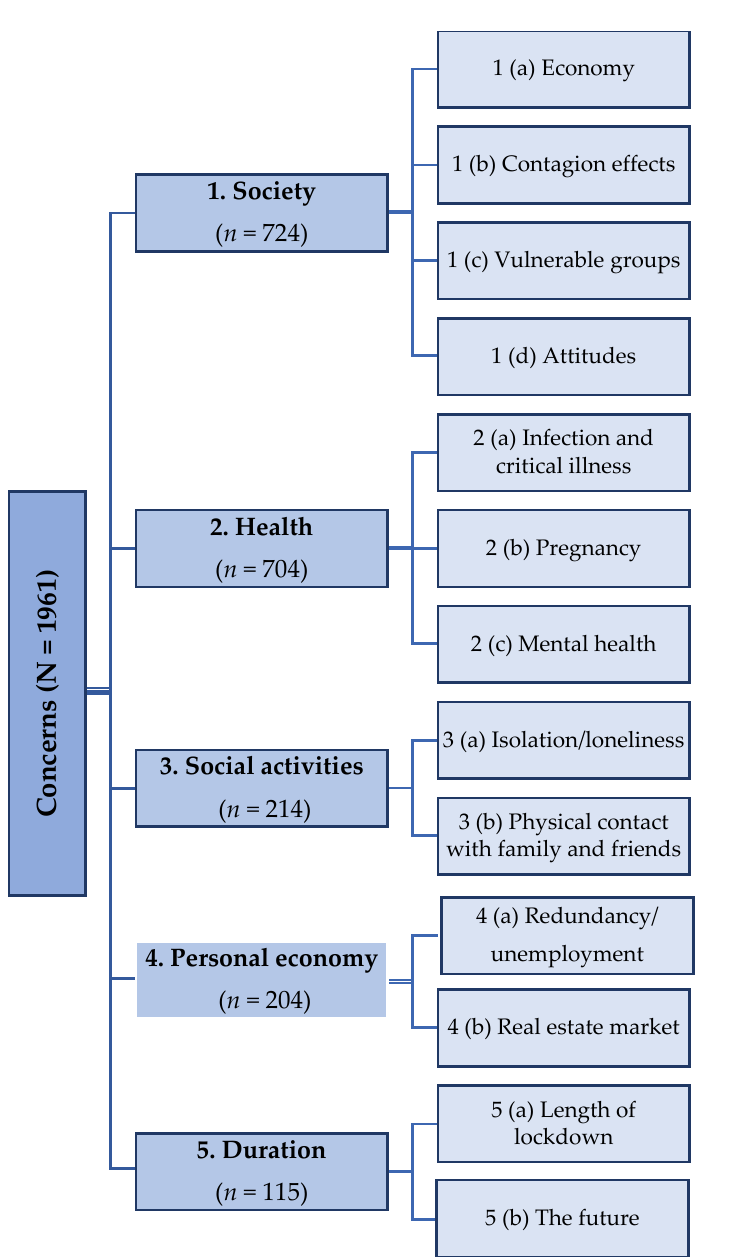
Figure 2. Themes and sub-themes from the qualitative analysis.